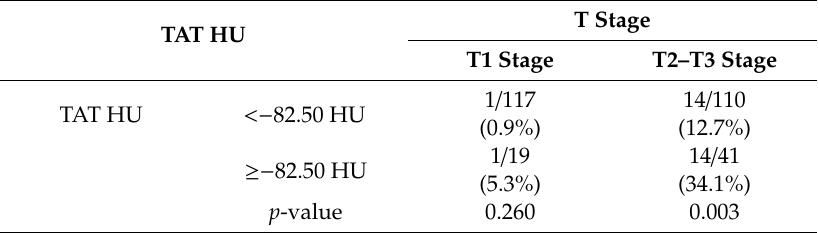
Table 5. Recurrence rates according to the combination of T stage and TAT HU.